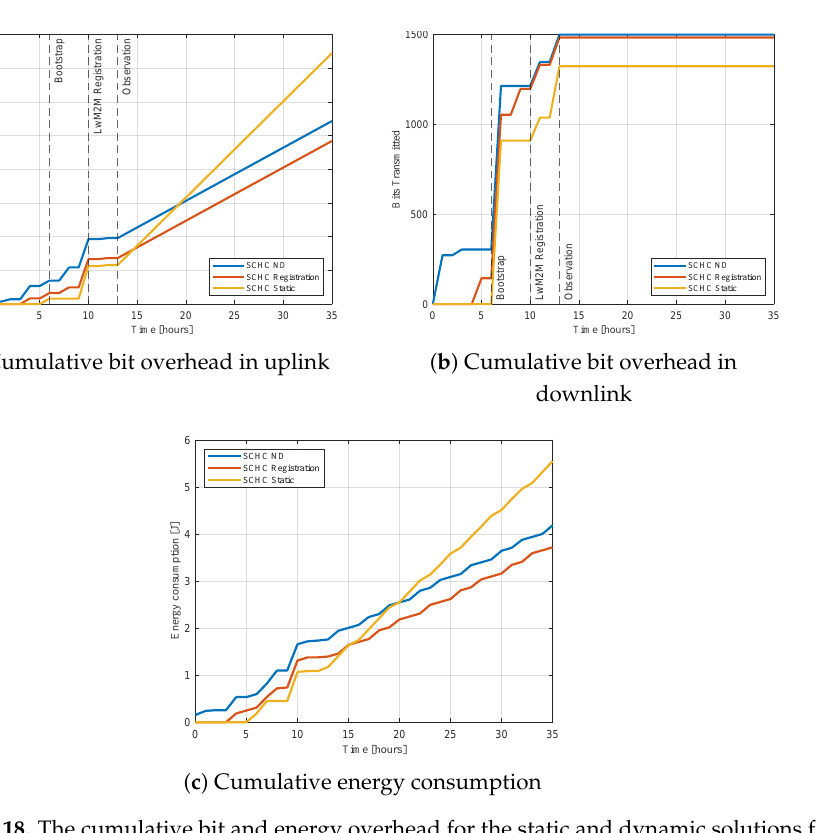
Figure 18. The cumulative bit and energy overhead for the static and dynamic solutions for a LoRa SF12 device observing its temperature value every